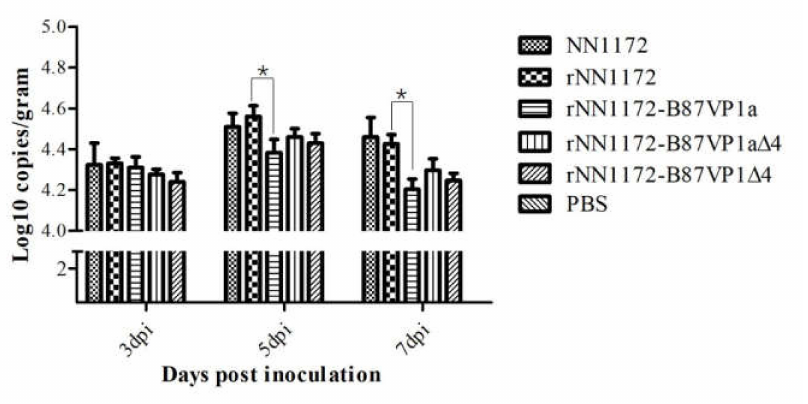
Figure 3. Growth curve of the mosaic recombinant IBDV strains in the infected chickens at 3, 5, and 7 dpi. * means significantly different ( p <